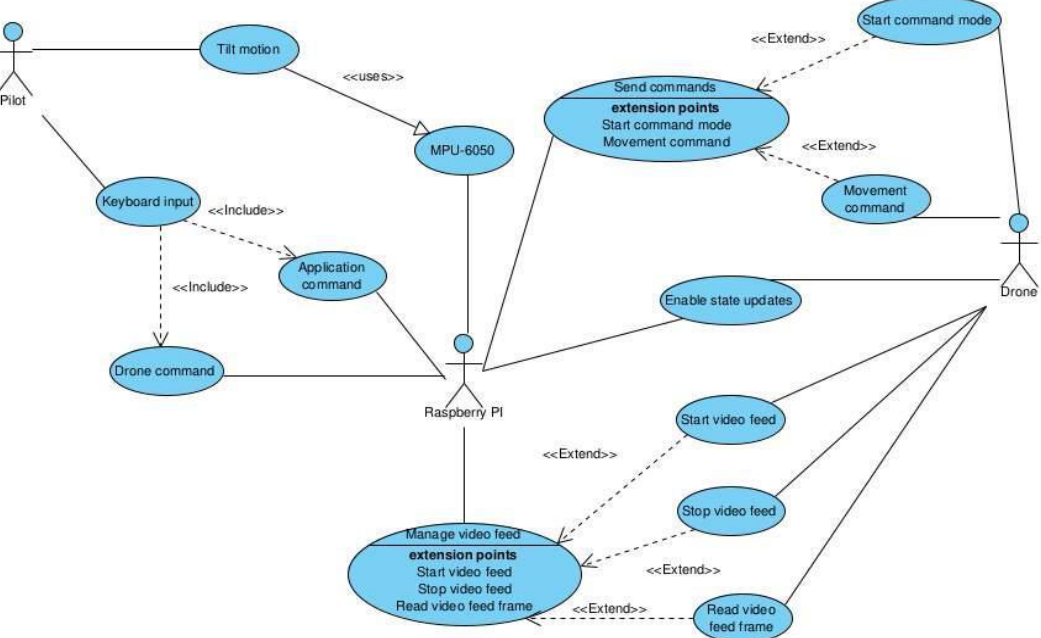
Figure 12. The UML Use Case Diagram detailing the general commands that a user can make and how they are processed and sent to the drone.